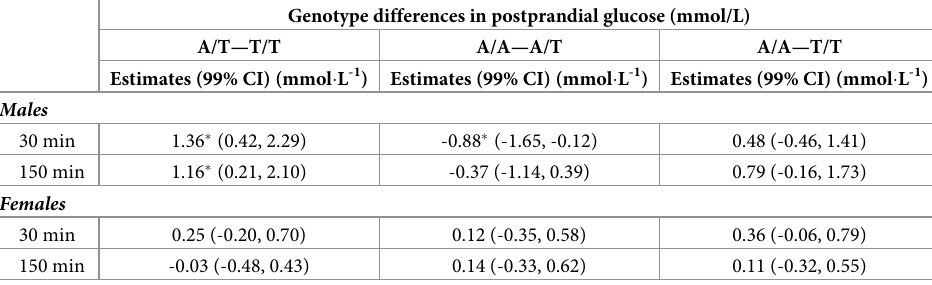
Table 2. Genotype differences in postprandial glucose for time points 30 min and 150 min for males and females as estimated by the LMM